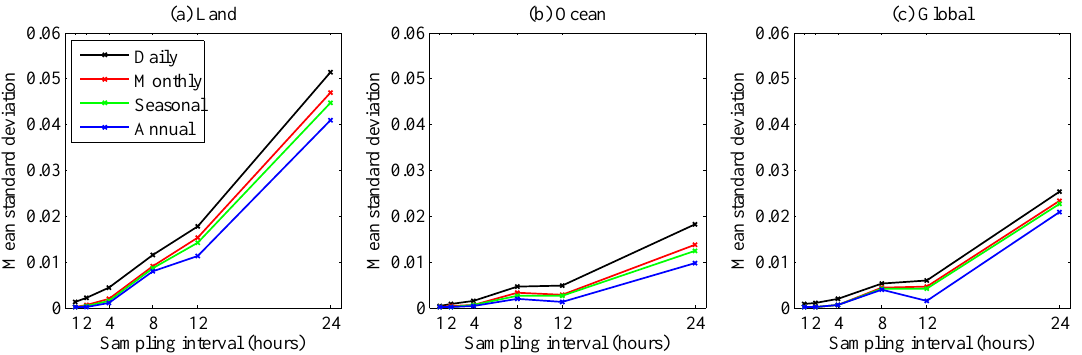
Figure 7. The mean of the standard deviations σ r , n for ( a ) land; ( b ) ocean; and ( c )